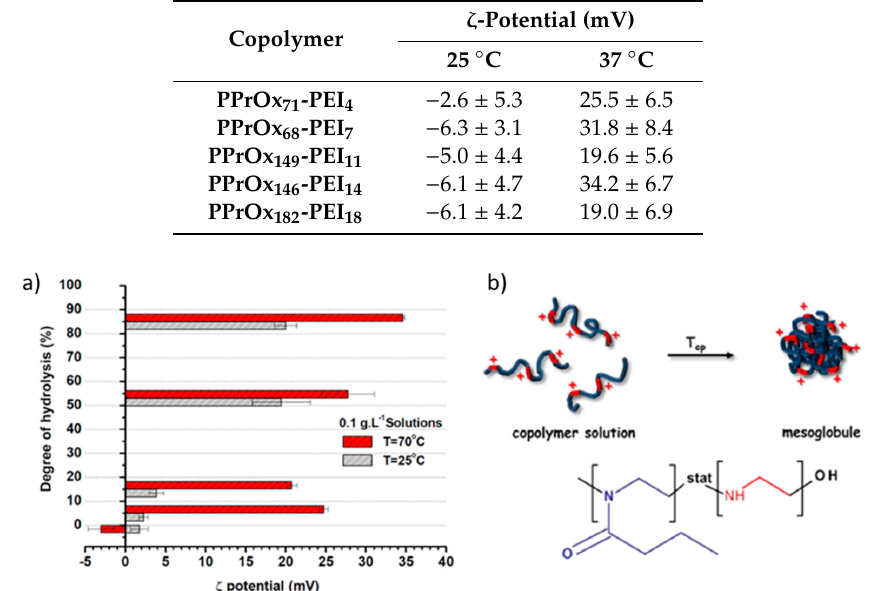
Figure 3. Variations of hydrodynamic diameters (D h ) with temperature for aqueous dispersions of PiPOx–PEI copolymers of degrees of hydrolysis of 15% ( left ) and 53% ( right ) and concentrations of 0.05 mg / mL (triangles) and 0.1 mg / mL (circles). Phase transition temperatures are determined as the onset of aggregation. Adapted from Toncheva-Moncheva et al. as published by the Elsevier [42]. Table 2. Variations of ζ potential of PnPOx–PEI copolymers with temperature and PEI content. The copolymer concentration was 10 mg / mL. Adapted from Mees et al. as published by the American Chemical Society [41].